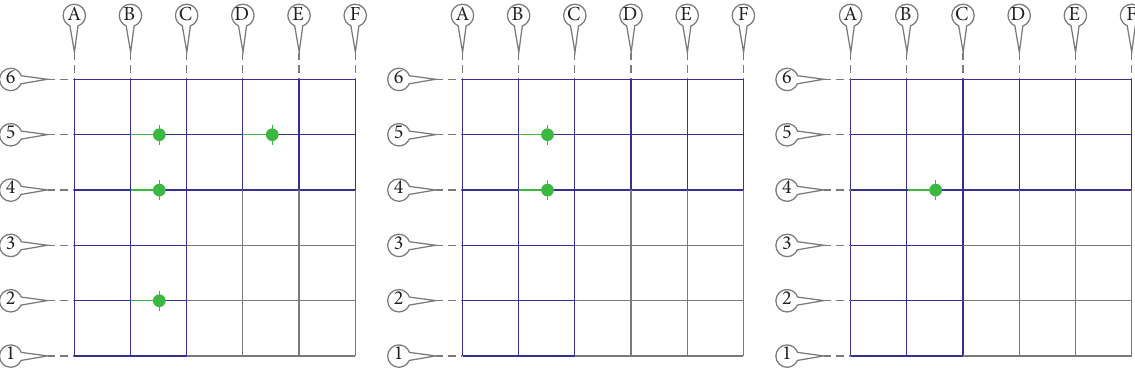
Figure 5: Damper at one point (right), dampers at two points (middle), and dampers at four points